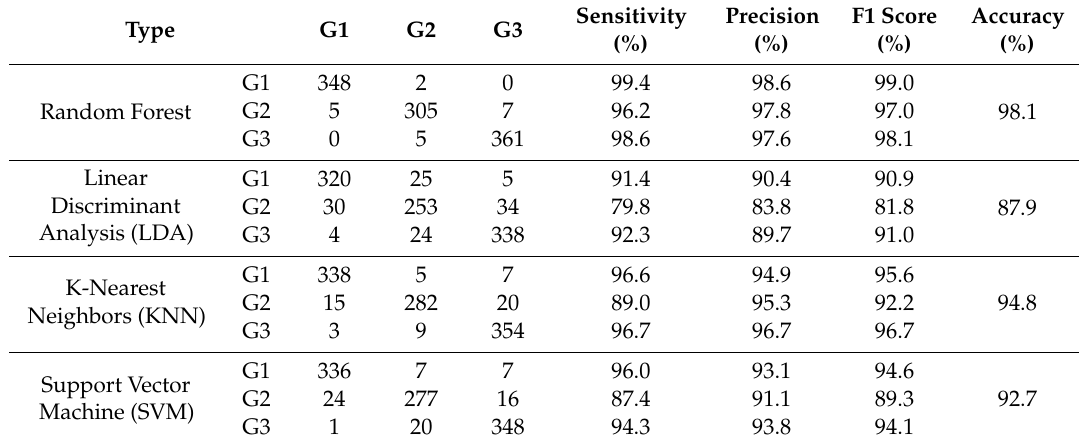
Table 5. The accuracy of